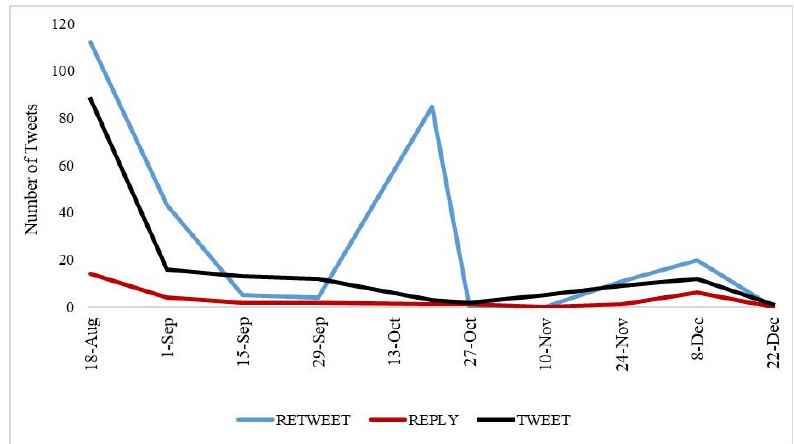
Figure 1. Number of tweets during the study period (18 August–31 December 2016).